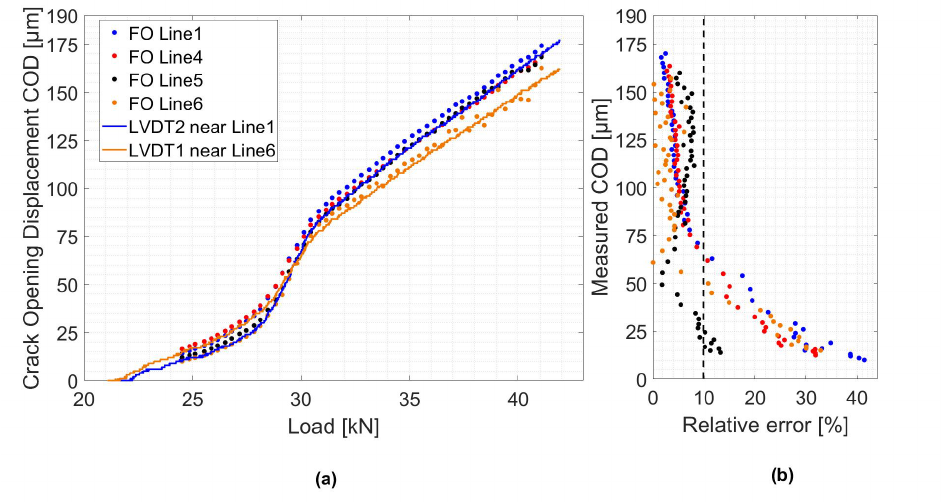
Figure 12. (a) Estimated crack openings compared to LVDT measurements. (b) Relative error compared to LVDT